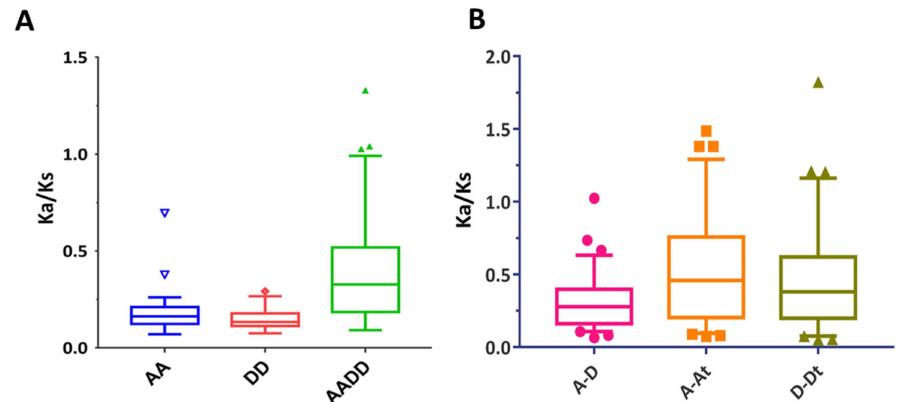
Figure 3. Ratios of non-synonymous to synonymous substitutions (Ka/Ks) in NPF genes. ( A ) Ka/Ks ratios of intraspecific duplicated gene pairs in G. arboreum (AA), G. raimondii (DD), and G. hirsutum (AADD); ( B ) Ka/Ks ratios of orthologous gene pairs between G. arboreum (AA) and G. raimondii (DD), G. arboreum (AA) and At sub-genome of G. hirsutum , G. raimondii (DD), and Dt sub-genome of G. hirsutum